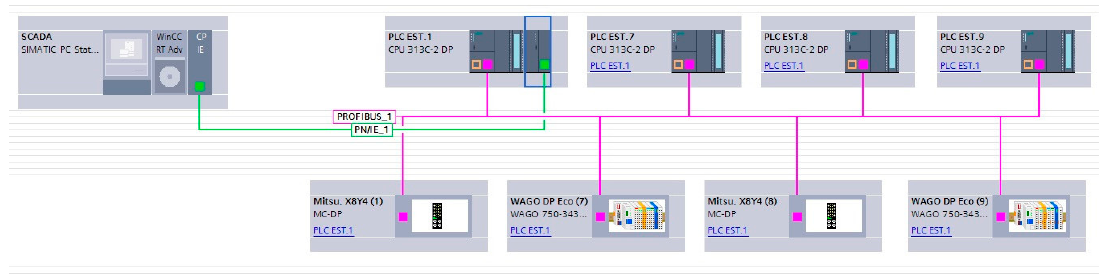
Figure 16. Network View of TIA Portal including PROFIBUS and Ethernet networks.